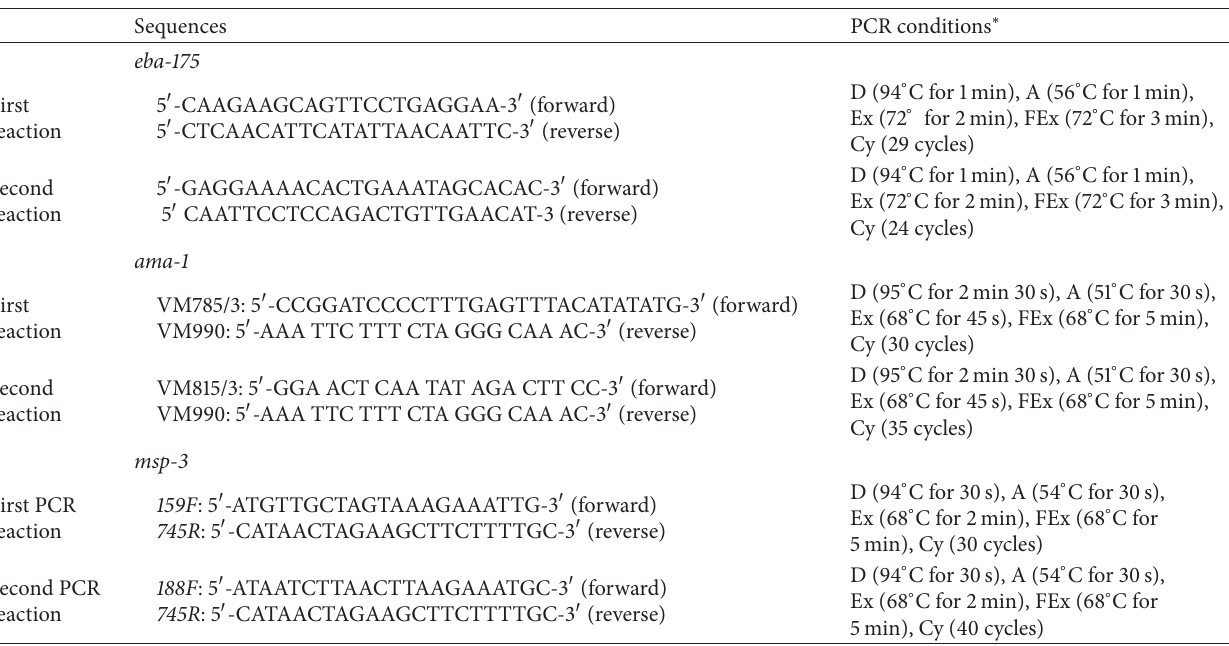
Table 1: Sequences of the primers and PCR